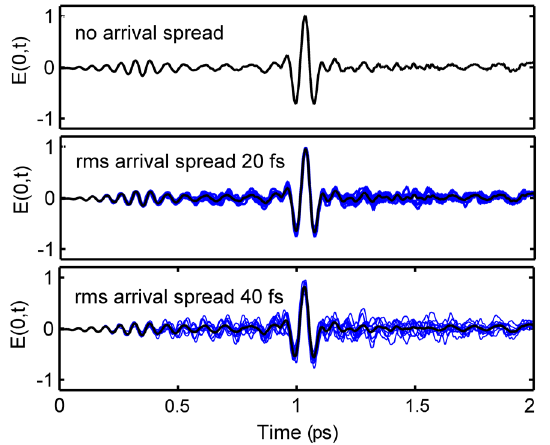
FIG. 10. On-axis E ð t Þ vs the time taking into account the spread of the arrival time of the bunches. The results for ten shots and the averaged value are depicted.